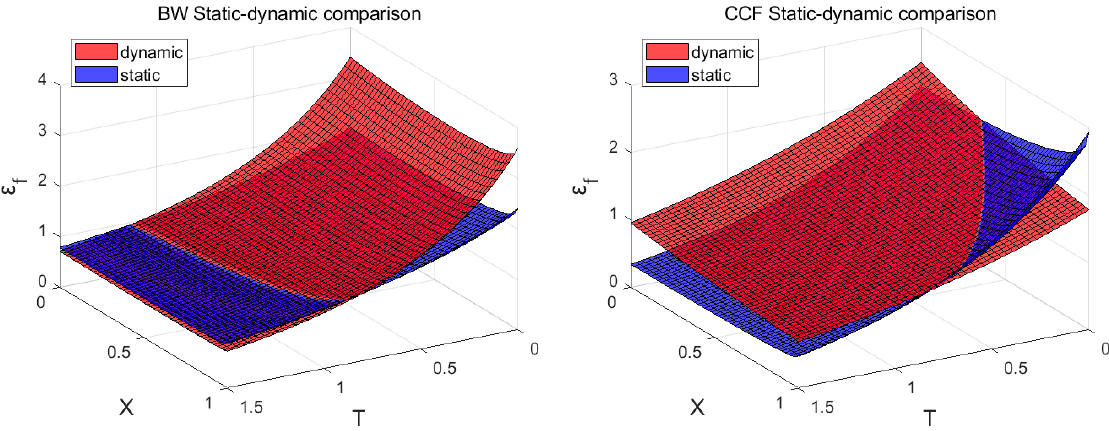
Figure 12. Comparison between the fracture surfaces of the CCF and BW models, obtained under static and dynamic conditions; case of JC plasticity model.